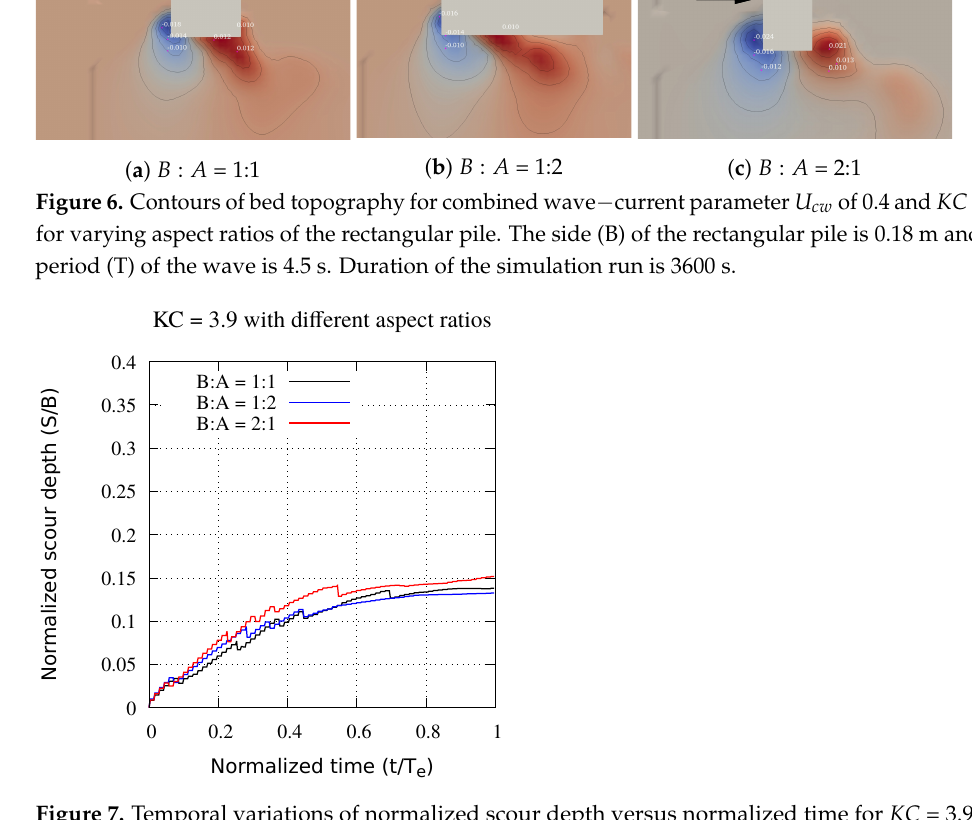
Figure 7. Temporal variations of normalized scour depth versus normalized time for KC = 3.9 and combined wave–current parameter U cw = 0.40. The wave period (T) is 4.5